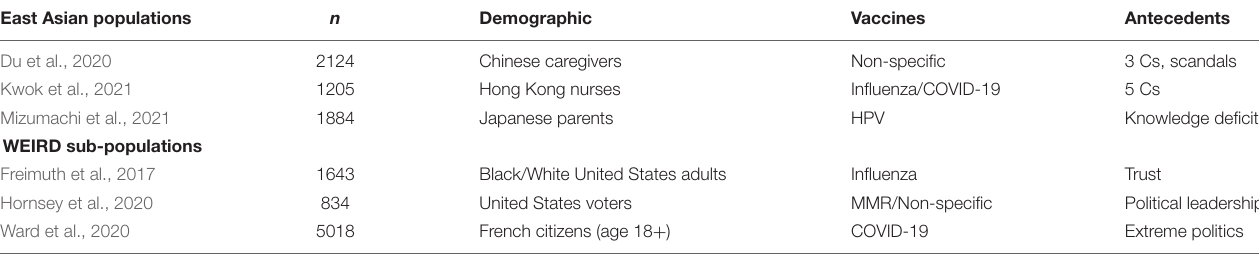
TABLE 1 | Overview of